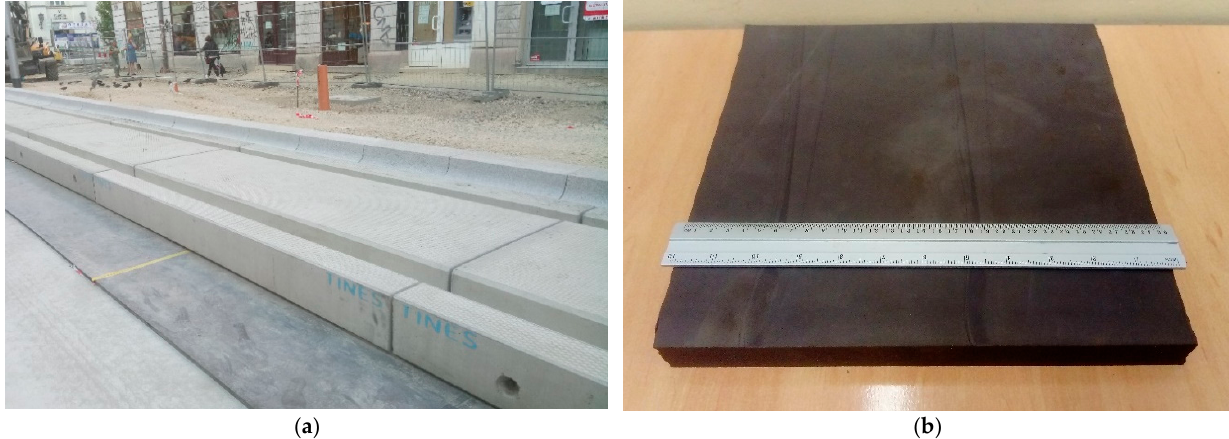
Figure 1. ( a ) Vibroinsulating mat built into the street tram track; ( b ) sample prepared for testing (300 × 300 × 25 mm³).